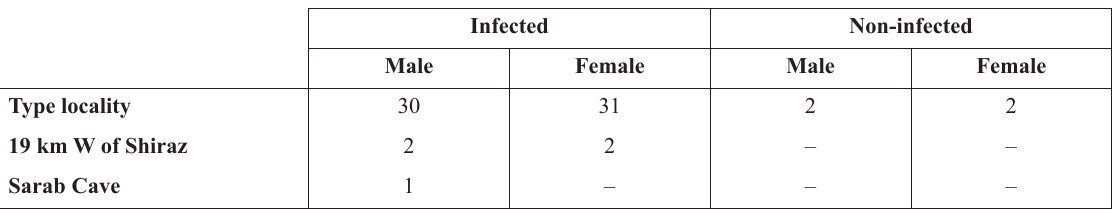
Table 1. Numbers of Chiraziulus kaiseri (Mauriès, 1983) specimens infected with the ectoparasitic fungus Rickia